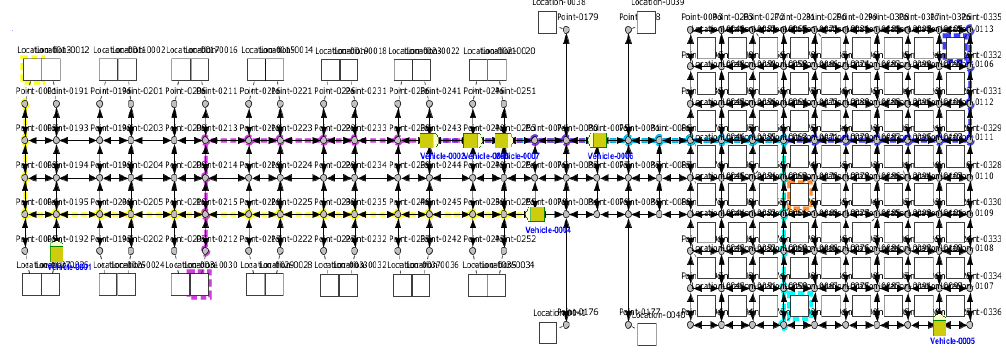
Figure 16. Multi-AGV operation.